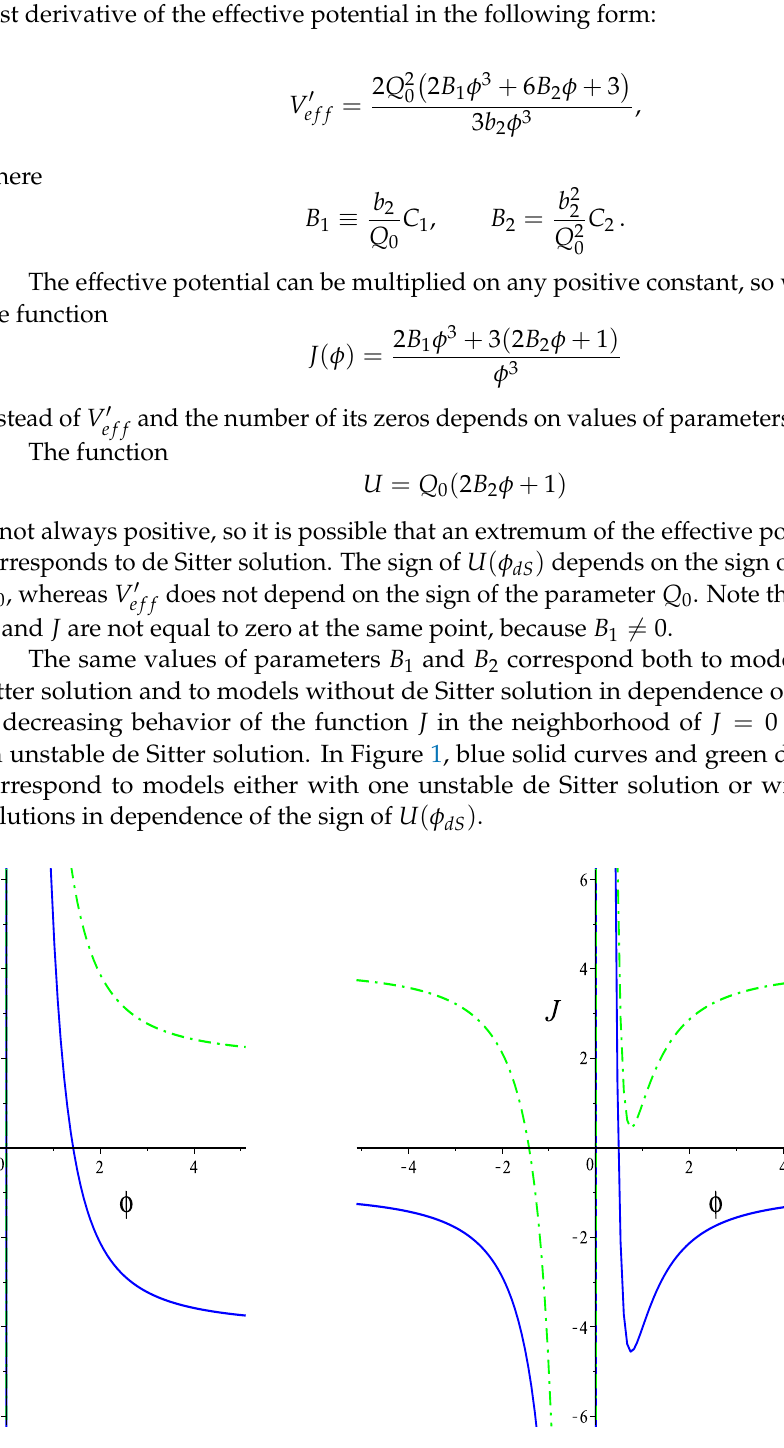
Figure 1. The function J ( φ ) for different values of parameters: B 2 = 1, B 1 = − 2 (blue solid curve) and B 1 = 1 (green dash-dot curve) ( left ); B 2 = − 1, B 1 = − 1/2 (blue solid curve) and B 1 = 2 (green dash-dot curve) ( right